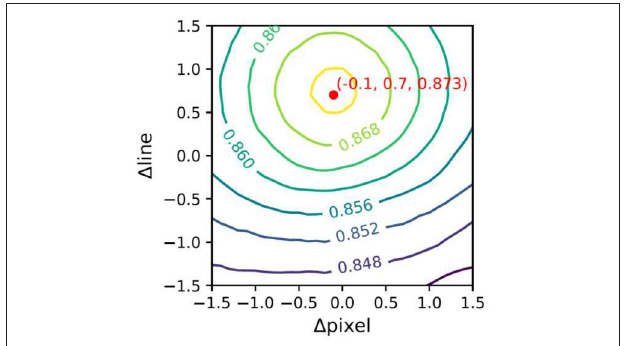
FIGURE 7 | AHI-CALIOP cloud mask hit rate as function of pixel and line displacement (in AHI pixels, see text), indicating a geolocation differences between AHI and CALIOP of − 0.1 AHI pixels ( ∼ 200m) and 0.7 AHI lines ( ∼ 1,400m), or a direct line difference of 1,414m. These are shown in red and the third value in that array is the maximum cloud hit rate. Hit rate is calculated for all conditions (total clear to overcast) over land and water for the region (110 ◦ E , 155 ◦ E , 10 ◦ S , 45 ◦ S ) from 6th Jul 2015 to 30th Jun